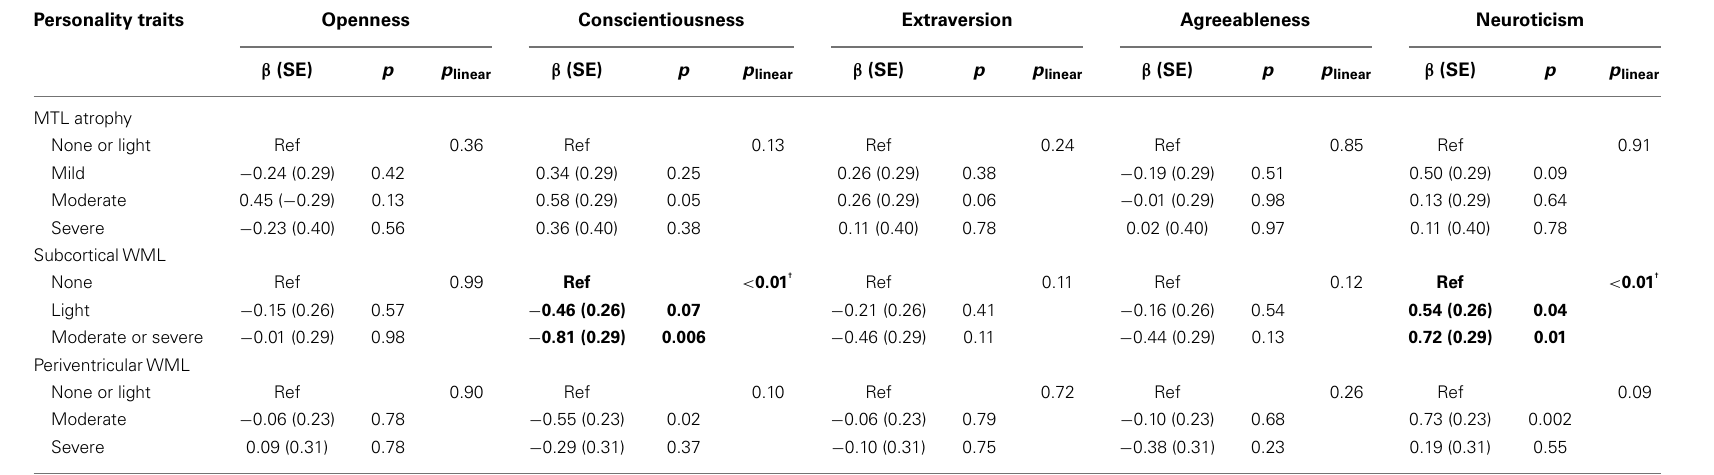
Table 5 |Association of personality traits and lacunes, MTL atrophy, subcortical, and peripheralWML adjusted for age, sex, and education level . Personality traits